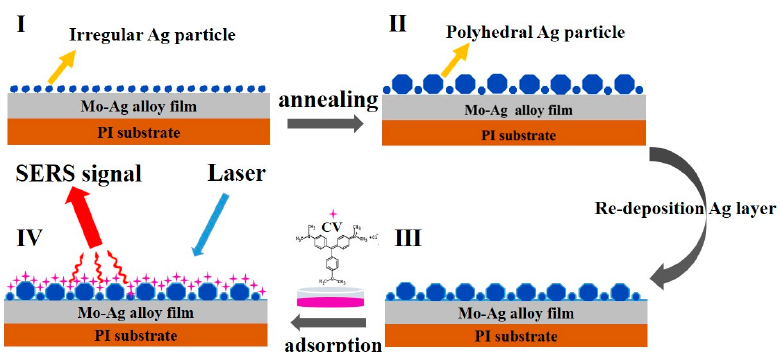
Figure 3. Schematic diagram of the Ag layer/annealed Mo-48.2% Ag film formation: ( I ) Mo-48.2% Ag films were prepared on PI substrate at room temperature; ( II ) the Mo-48.2% Ag film annealed in argon atmosphere; ( III ) an Ag layer was further sputtered on the annealed Mo-48.2% Ag films; ( IV ) the surface-enhanced Raman scattering (SERS) performance of the Ag layer/annealed Mo-48.2% Ag film was